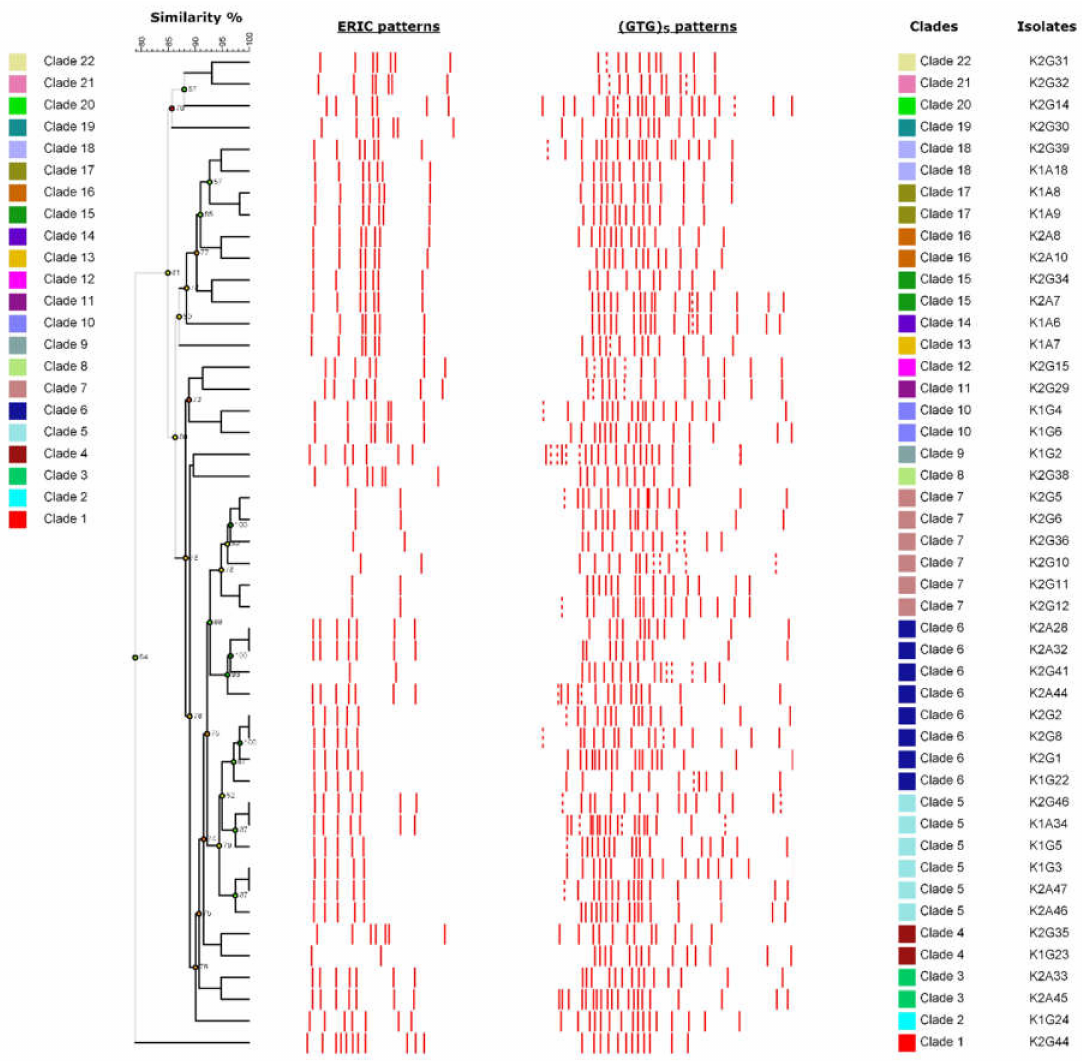
Figure 4. Dendrogram obtained combining the digitalized patterns from both (GTG)5 rep-PCR and ERIC rep-PCR. The dendrogram was drawn from UPGMA analysis using Dice’s coefficient. The discrimination of biotypes was performed considering a similarity threshold of 94%. The cophenetic coefficient is represented by numbers and dots colored as red–orange–yellow–green, based on the branch quality. Cluster colors were defined in agreement with the Figure